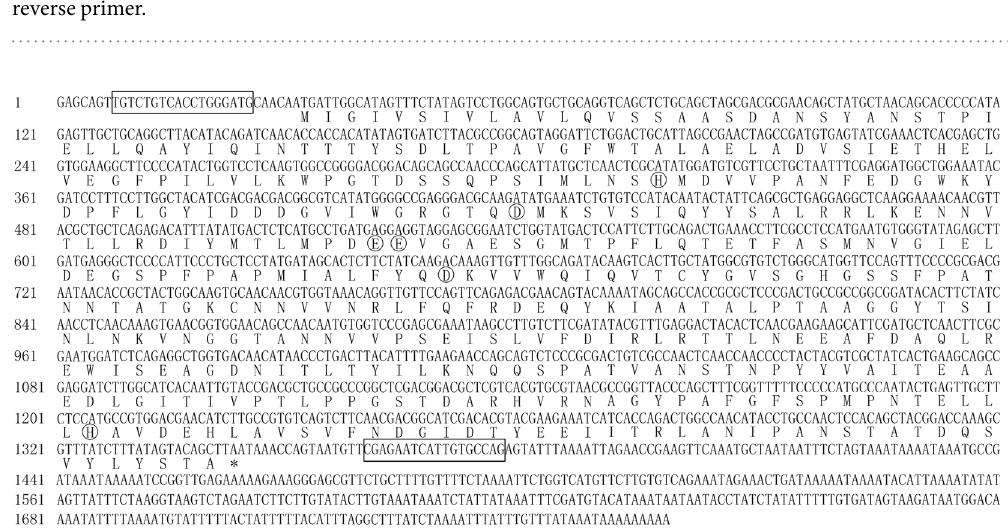
Figure 1. The full length cDNA sequences of H. assulta L-ACY-1 . ○ = zinc-binding site of L-ACY-1.